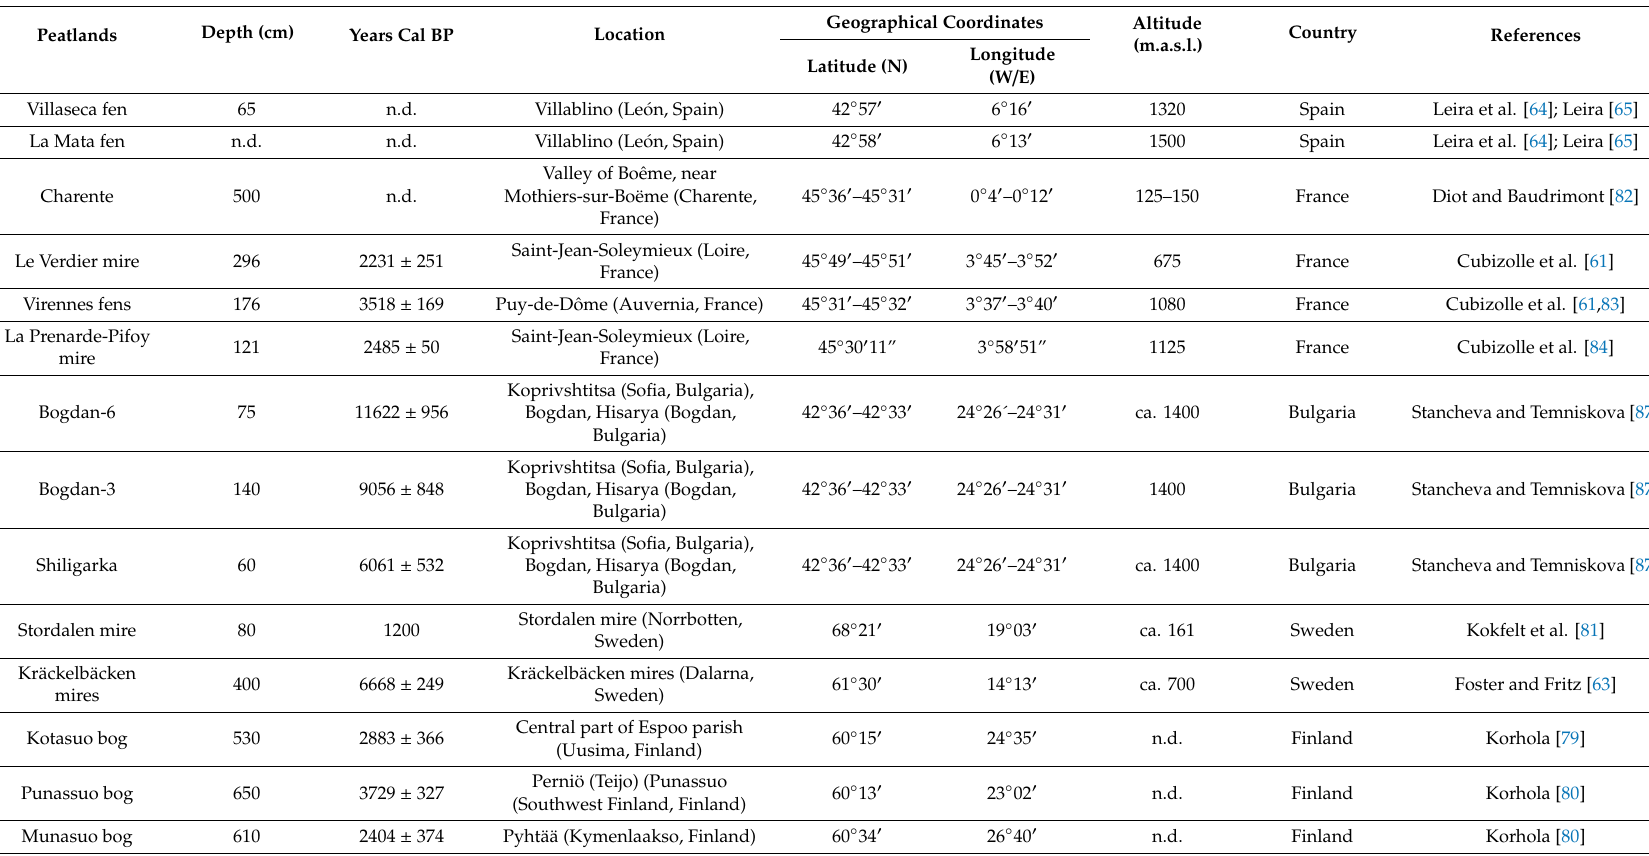
Table 1. List of peatlands in Europe, below the 47 ◦ N parallel the Southern Europe peatlands, in which diatoms have been used in studies of paleoenvironmental